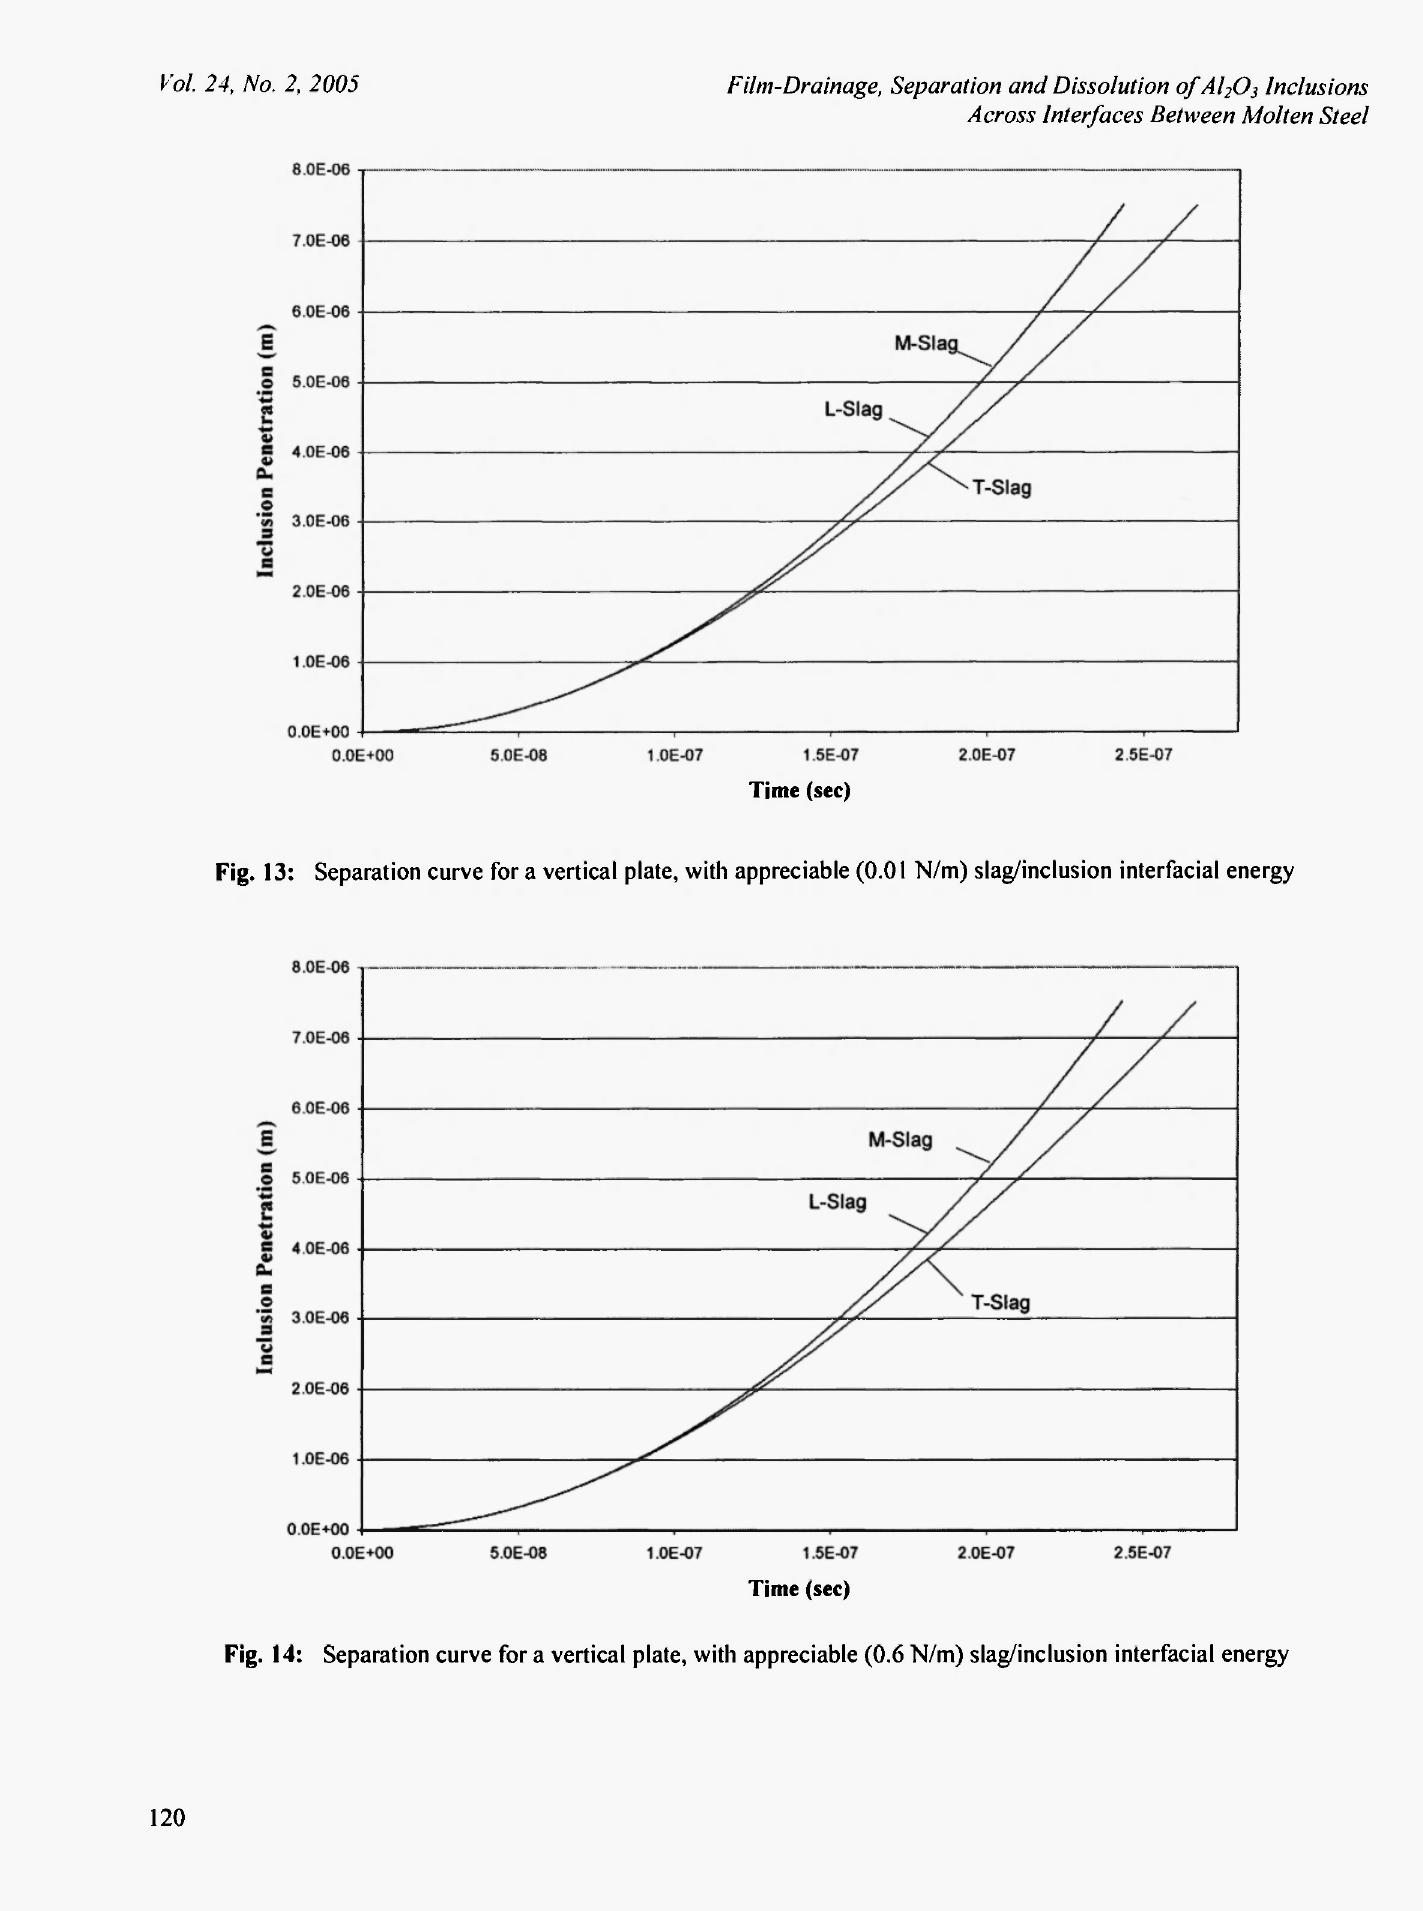
Fig. 14: Separation curve for a vertical plate, with appreciable (0.6 N/m) slag/inclusion interfacial energy